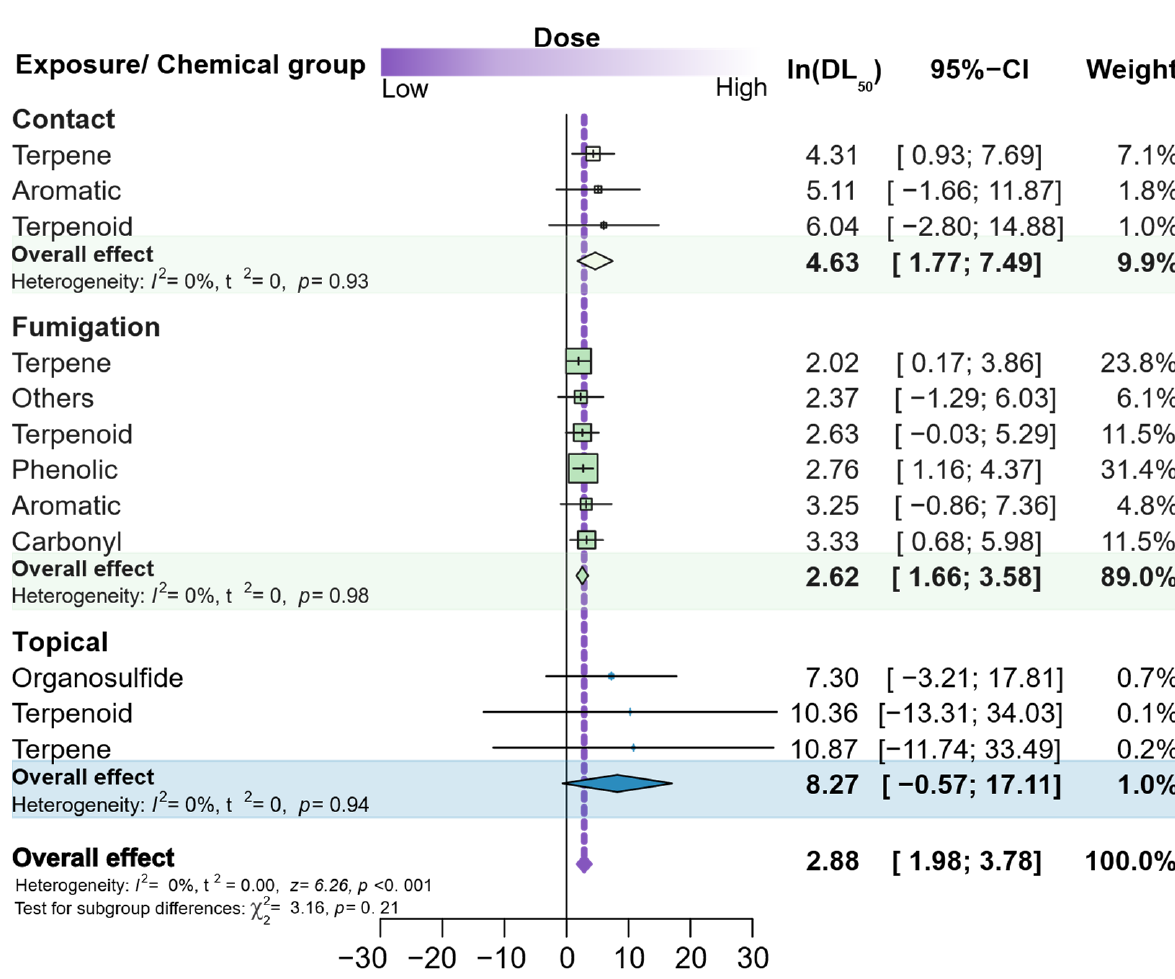
Figure 9. Forest plot summarizing the quantitative meta-analysis comparing the LD 50 s, as toxicity endpoints, in papers assessing the insecticidal activity of phytochemicals. The meta-analysis is divided into modes of exposure and phytochemical group. Doses (ppm) were transformed by natural logarithm. The average LD 50 s are denoted by boxes (horizontal lines), and the box size refers to the number of populations reported for the phytochemical group; the 95% CIs are represented by horizontal lines. The combined LD 50 estimates for overall trends is represented by a diamond, where the diamond width corresponds to 95% CI bounds. The vertical dashed line shows the overall estimated effect resulting from all species. The p -values for the heterogeneity test are indicated (number of papers = 12).